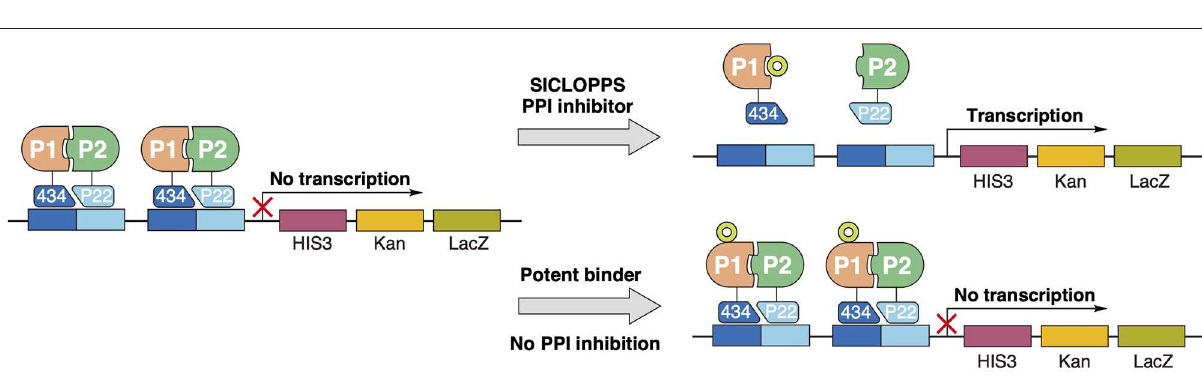
FIGURE 8 | Peptide selection through reverse two-hybrid screening. Complementation of the transcription repressor domains 434 and P22, conjugated to the interaction proteins of interest, blocks the transcription of essential survival genes downstream. Only functional disruption of the target PPI interaction can restore transcription of the essential downstream genes and form a viable cell line. In contrast to other conventional screening methodologies, potent binding to the target will not constitute a “hit” unless this binding can functionally inhibit the targeted